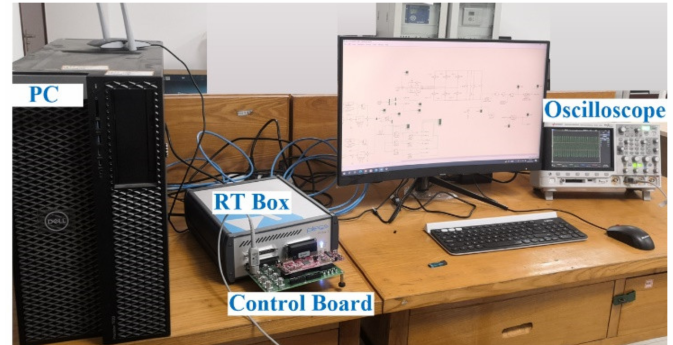
Figure 13. Hardware-in-the-loop experimental platform.